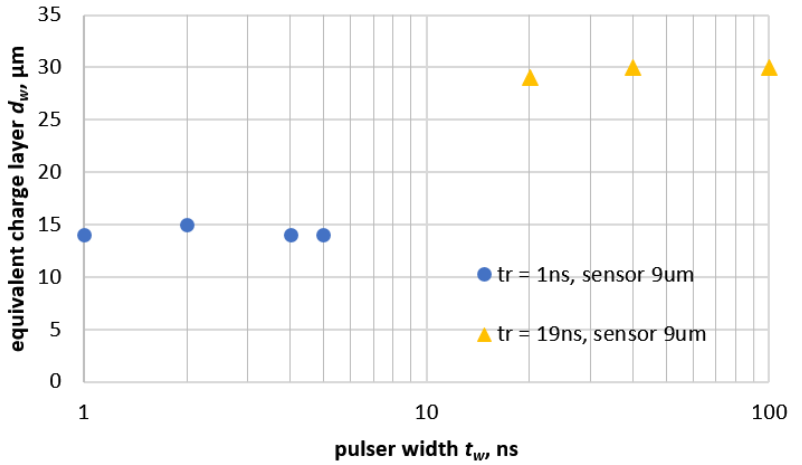
Figure 8. Comparison of the equivalent charge layer d w calculated for different pulser widths t w and different pulser rise times t r .